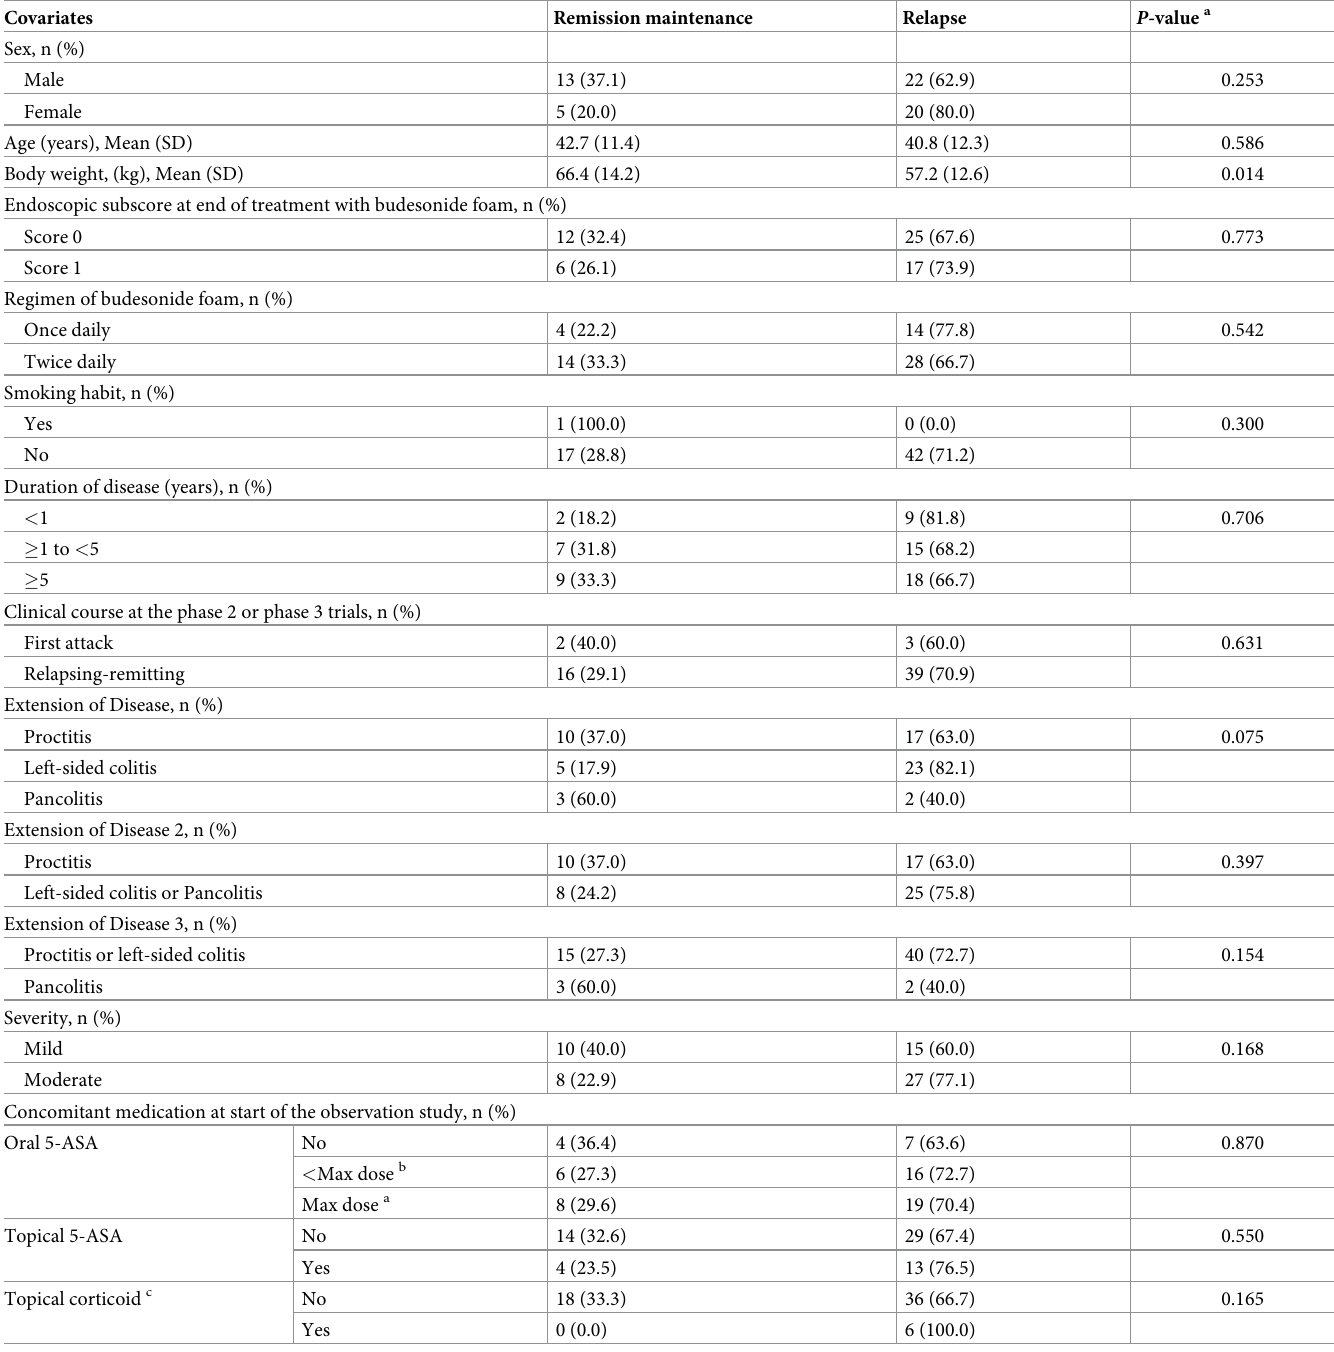
Table 2. Proportion of patients with/without relapse during the observation period by